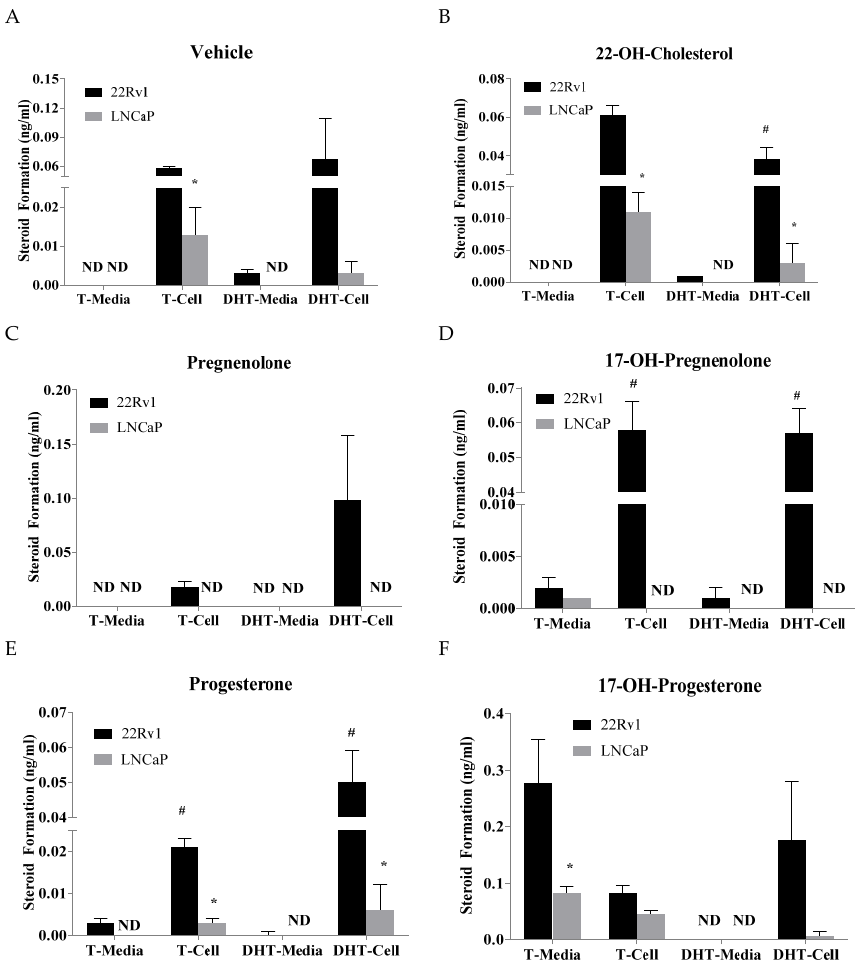
Figure 2. Testosterone (T) and dihydrotestosterone (DHT) levels (ng/mL) in LNCaP and 22Rv1 cell culture media and pellet, following incubation with 2 µ g/mL 22-OH-cholesterol (panel B ), pregnenolone (panel C ), 17-OH-pregnenolone (panel D ), progesterone (panel E ), 17-OH-progesterone (panel F ) or vehicle (panel A ) for 48 h. * represents statistically significant difference ( p < 0.05) between 22Rv1 and LNCaP cells when comparing either T or DHT in either cell pellet or media. # represents statistically significant difference ( p < 0.05) between cell pellet and media in a single cell line for either T or DHT. Mean ± SEM values were obtained from three separate experiments performed on different